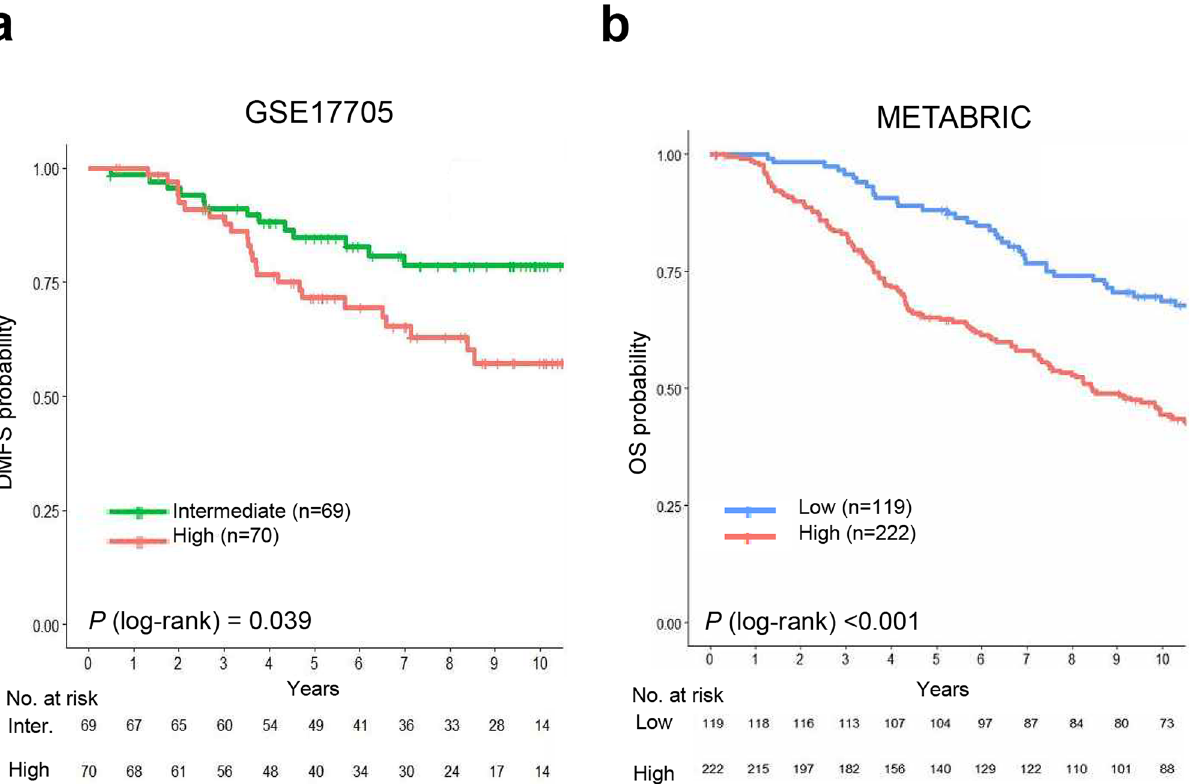
Figure 4. Kaplan–Meier plot of distant metastasis-free survival (DMFS) or overall survival (OS) for the validation datasets. ( a ) GSE17705 dataset and ( b ) METABRIC dataset. Patients in GSE17705 were stratified into intermediate- and high-risk groups, and patients in the METABRIC dataset were stratified into low- and high- risk groups, according to the immune prognostic index. Optimal cutoff points for the immune prognostic index used for risk classification were determined using maximally selected rank